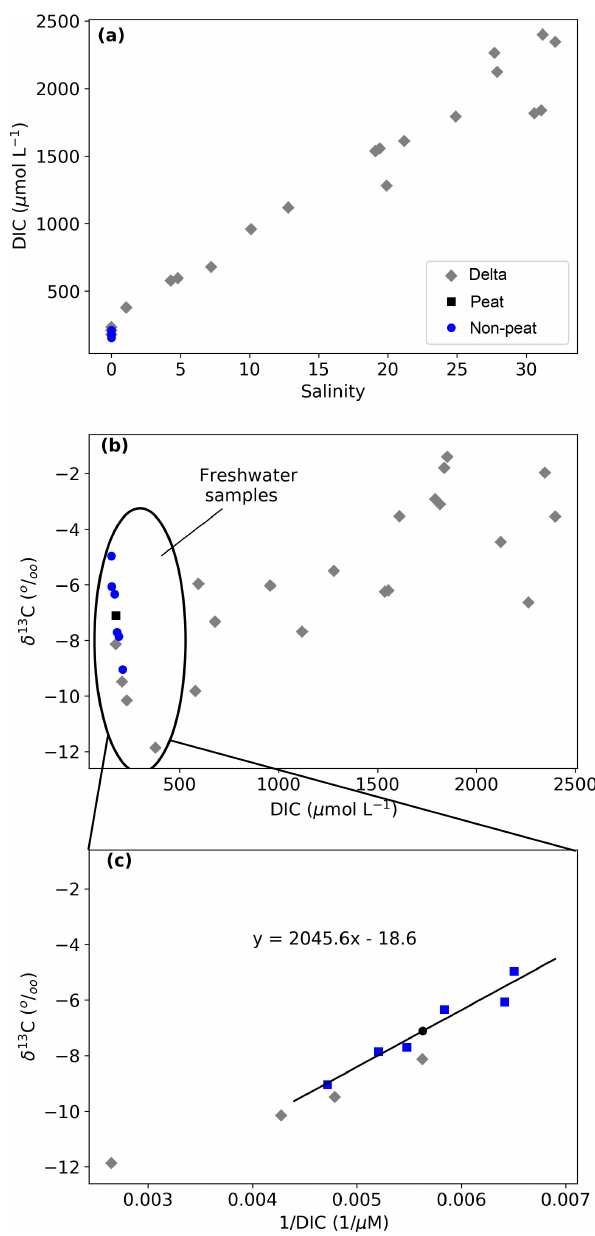
Figure 4. DIC vs. salinity (a) , δ 13 C vs. DIC (b) and a Keeling plot of δ 13 C vs. 1 / DIC for nonpeat, peat and delta samples, respectively. Freshwater samples, including those from the delta region, are cir- cled in panel (b) , and only those are shown in the Keeling plot in panel (c) . All data refer to dry-season samples.